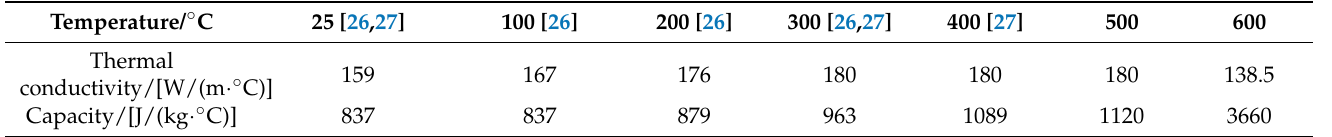
Table 3. Thermophysical parameters of 2A14-T4